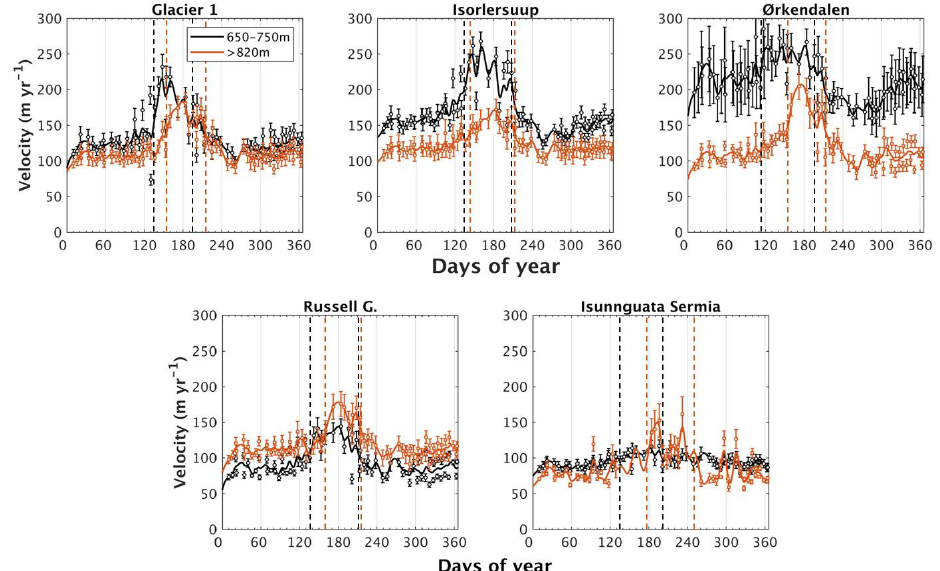
Figure 4. Seasonal changes in ice flow at two different elevations bands on each glacier. Actual measurements are represented by the dots, spline fits as continuous lines, and speedup periods the intervals between the consecutive coloured dotted lines.